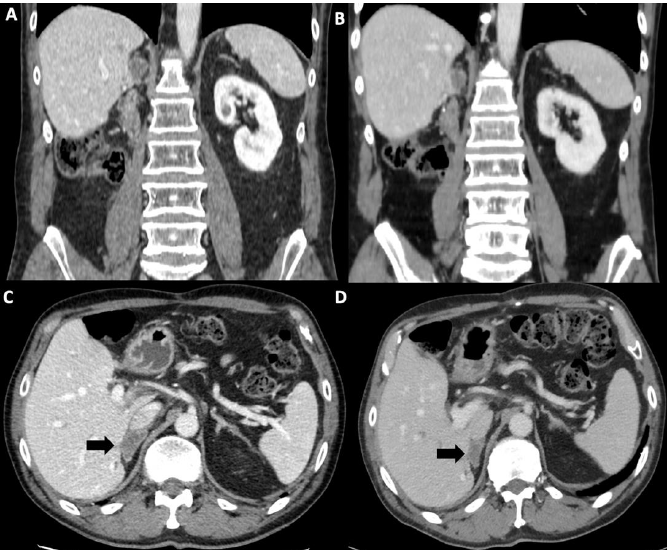
Figure 2. CT scans in a male patient, 69 years old, with metastatic RCC in the right adrenal gland before ( A , C ) and after medical treatment ( B , D ). CT images are reported in coronal views ( A , B ) obtained with multiplanar reformation and in axial views ( C , D ). The patient underwent right nephrectomy for the primary tumor (clear cell RCC) ( A , B ) and was medically treated with a flat dose of nivolumab (480 mg/4 weeks) after he developed the secondary adrenal lesion. CT images before medical therapy showed the presence in the right adrenal gland of an inhomogeneous hypodense metastatic lesion with irregular margins ( C , black arrow) that revealed a 32% decrease in size (28 mm vs. 19 mm) after medical treatment ( D , black arrow) reflecting a partial response according to iRECIST (Table 2).